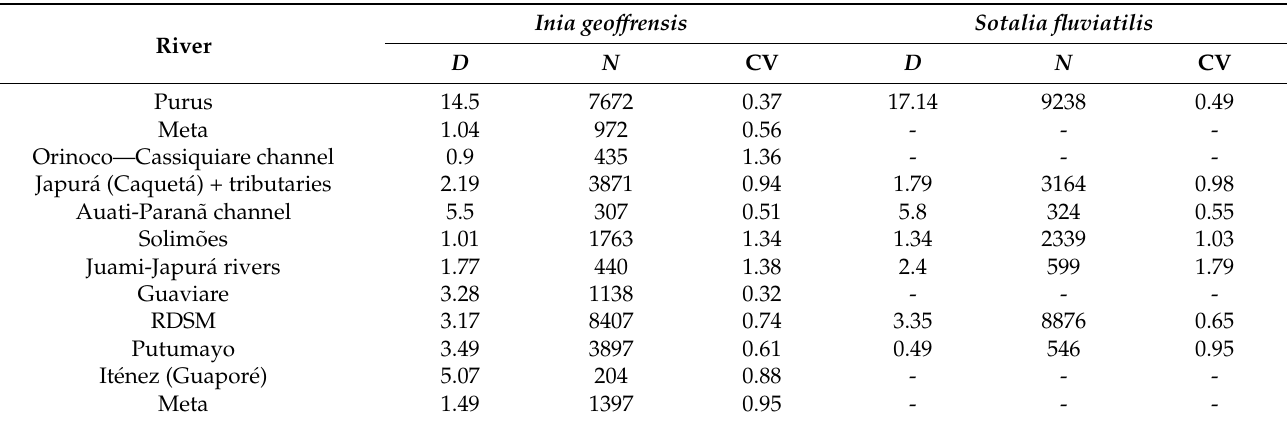
Table 2. Boto ( Inia geoffrensis ) and tucuxi ( Sotalia fluviatilis ) estimates of density and abundance across Amazon and Orinoco river